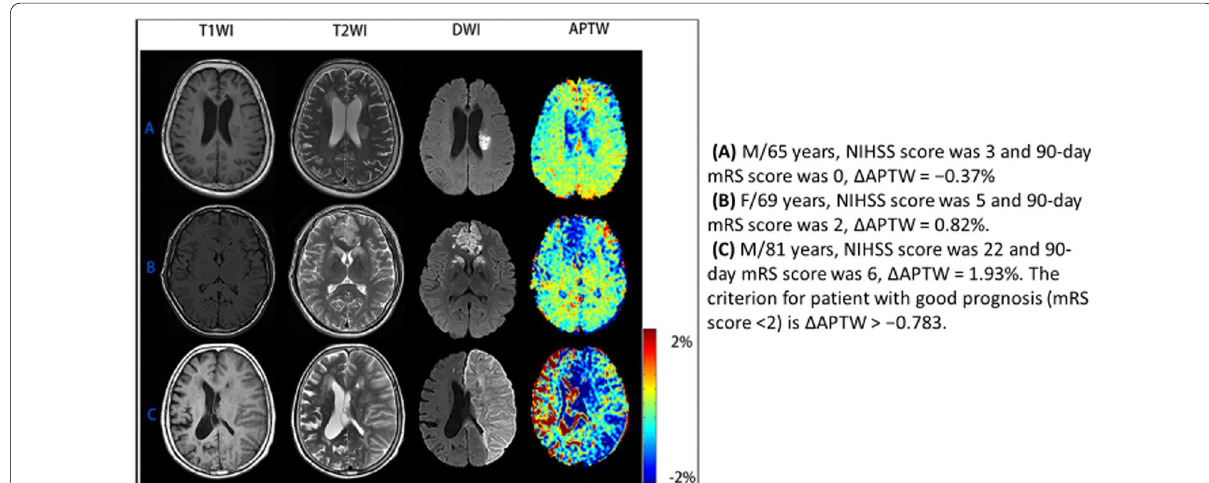
Fig. 3 Conventional structural MR images (T1- and T2-weighted imaging [T1WI/T2WI]) in the first and second column, diffusion-weighted image (DWI) in the third column, and amide proton transfer weighted imaging (APTW) in the fourth column from the left. Each row corresponds to images from an individual patient with acute ischaemic infarct and differing clinical reports [93]. Figure reproduced according to the Creative Commons Attribution (CC BY) license from: Lin et al. [93]. Copyright © 2018 Lin, Zhuang, Shen, Xiao, Chen, Shen, Zong and